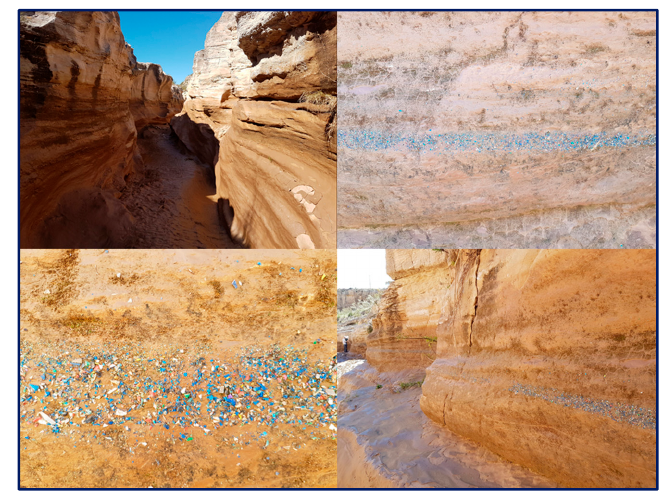
Figure 1. Appearance of the deposition and stratification of plastic materials in a Spanish canyon (Source: [16]).